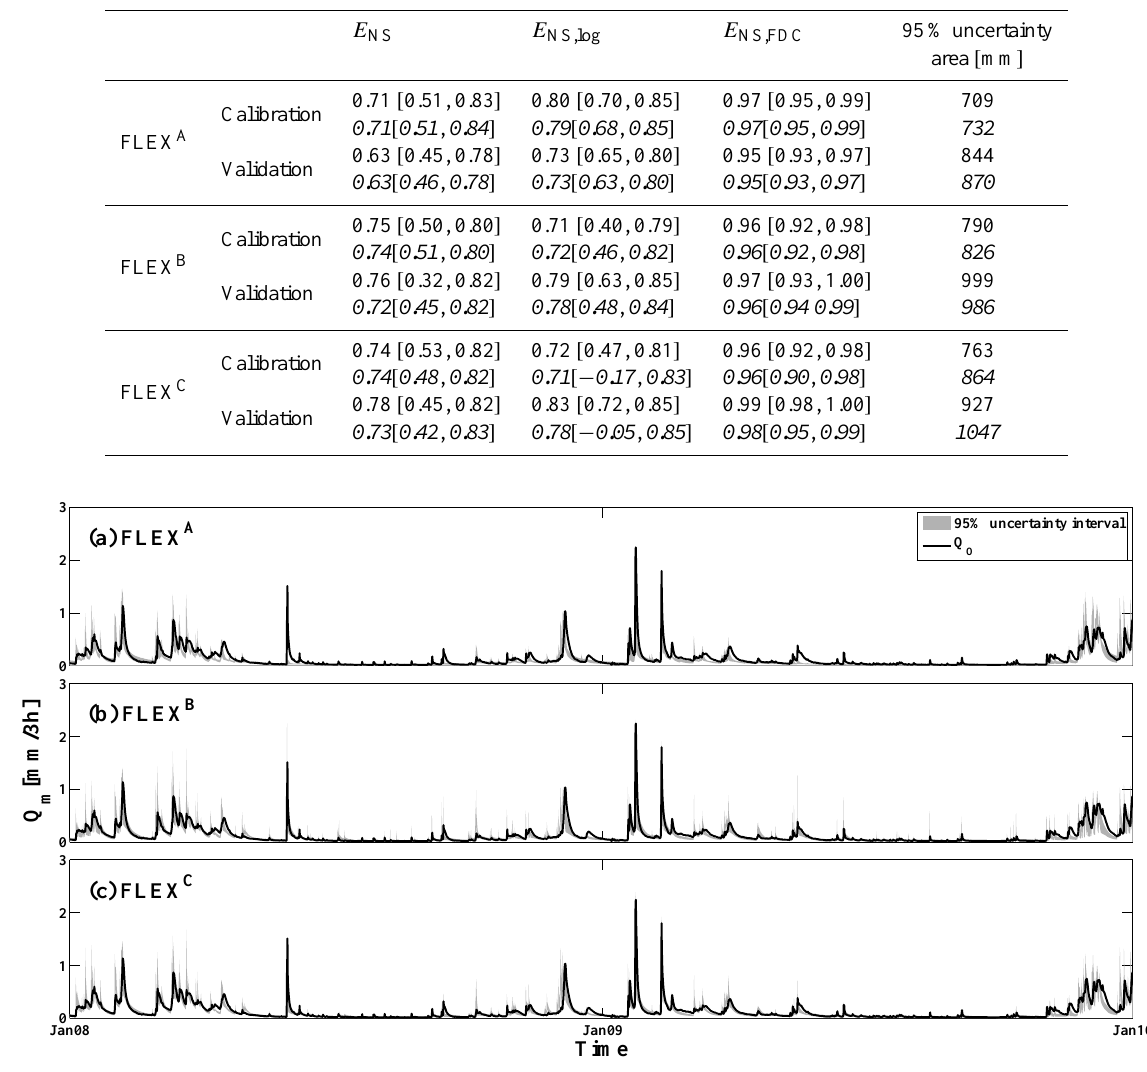
Figure 4. The observed hydrograph and the 95% Pareto uncertainty interval of the modeled hydrograph for constrained and calibrated parameter sets for the three different model setups (a) FLEX A , (b) FLEX B and (c) FLEX C for the 2 years (2008–2009) of validation period.